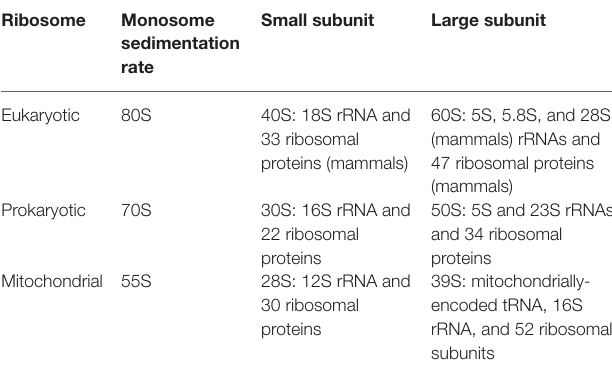
TABLE 1 | Composition of eukaryotic and prokaryotic small and large ribosomal subunits.